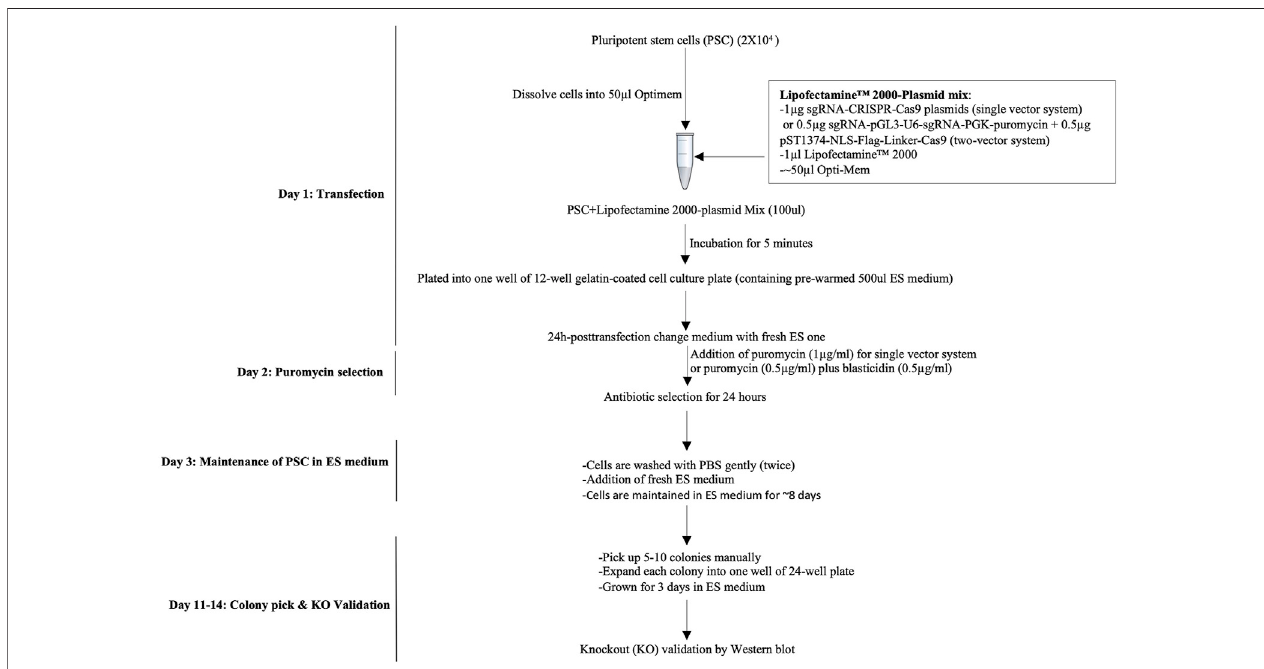
FIGURE 2 | Work fl ow of the CRISPR/Cas9-mediated knockout strategy in pluripotent stem cells. A work fl ow of the CRISPR/Cas9-assisted knockout strategy consists of transfection of PSCs under the single-cell stage, quick antibiotic(s) selection, and colony pickup for sustainable growth and knockout validation.